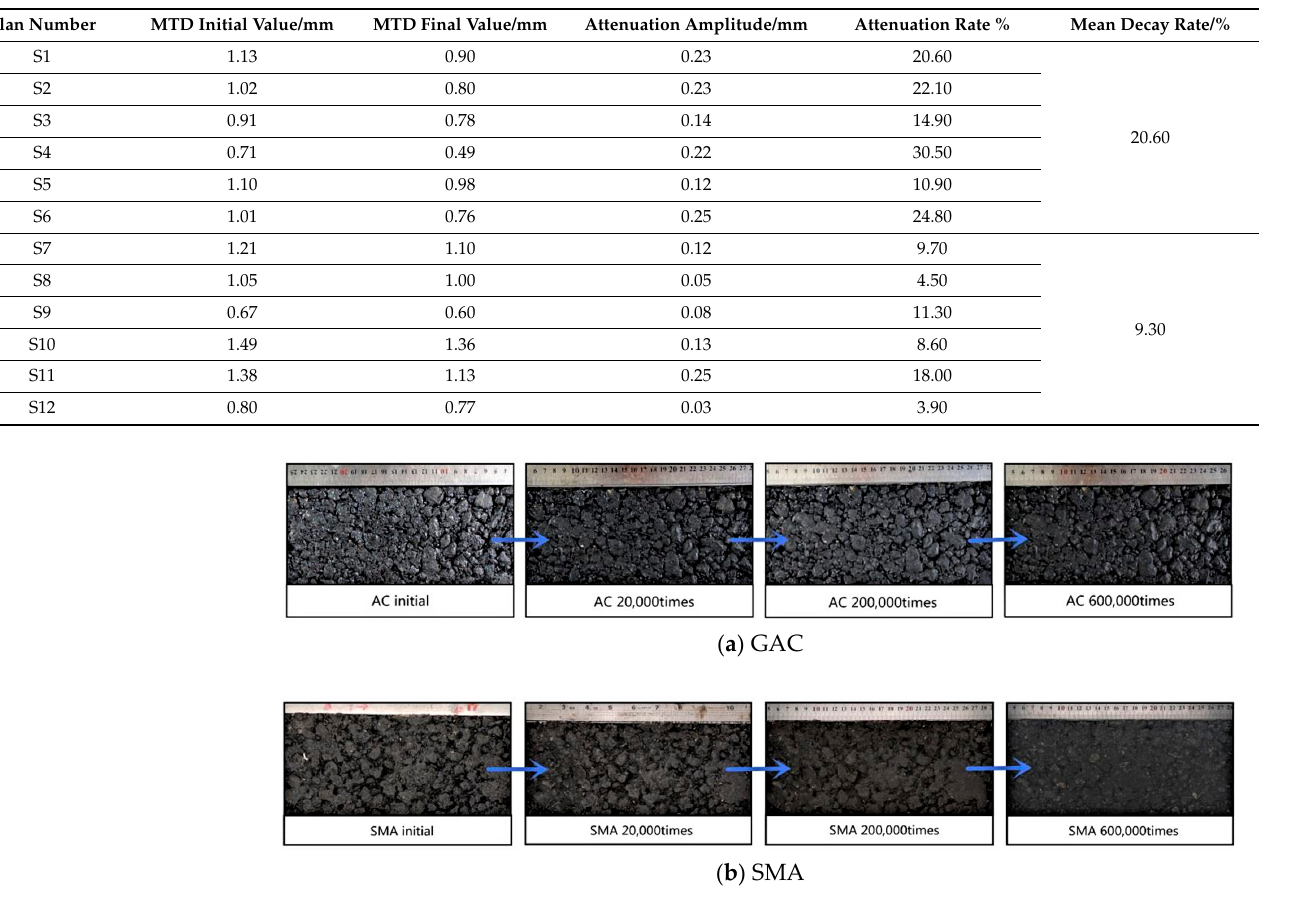
Figure 6. Surface changes of the asphalt mixture under different load repetitions.